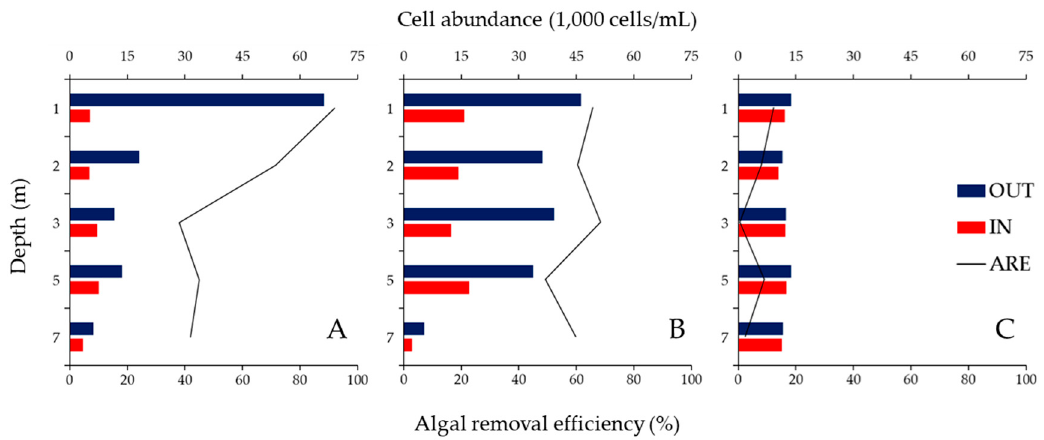
Figure 5. Daily variation in total phytoplankton and algal removal e ffi ciency at di ff erent depths on both sides (outside and inside the alternative algae-blocking mat (ABM)) of the Paldangho intake facility. OUT, reservoir water; IN, ABM-passed water. ( A ) 24 August at 2:00 p.m., ( B ) 24 August at 8:00 p.m., and ( C ) 25 August at 8:00